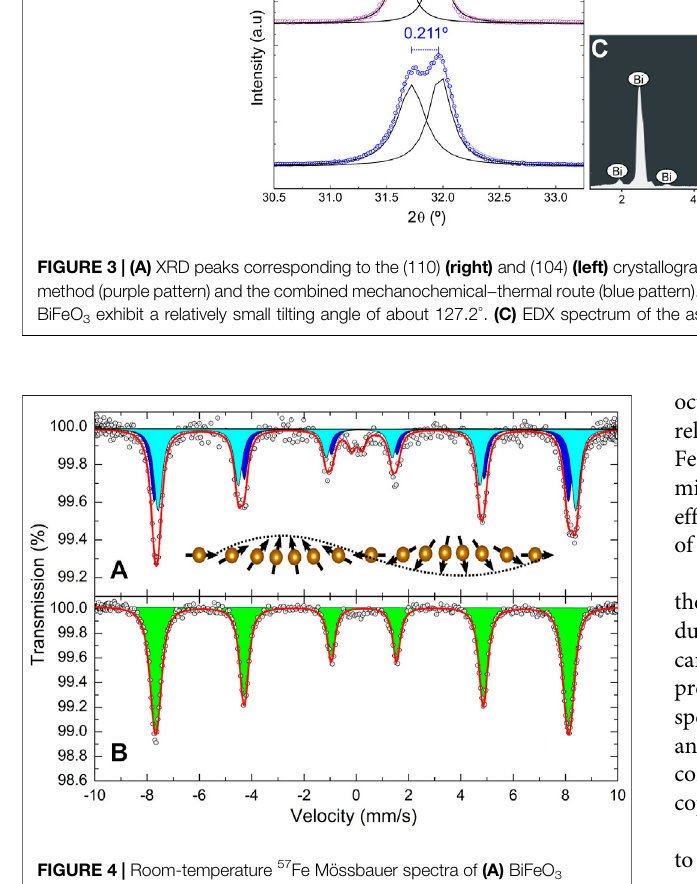
FIGURE 4 | Room-temperature 57 Fe Mössbauer spectra of (A) BiFeO 3 synthesized by the ceramic method and (B) BiFeO 3 prepared by the combined mechanochemical − thermal route. The inset schematically shows the cycloidal arrangement of spins in the reference BiFeO 3 synthesized by the ceramic